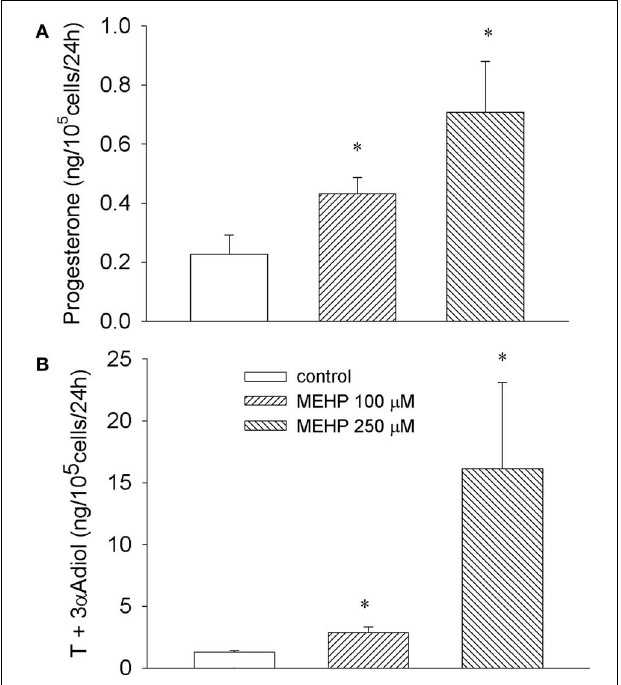
FIGURE 1 | Stimulatory effect of MEHP on basal steroidogenesis in immature granulosa cells (A) and Leydig cell progenitors (B). The cells were cultured without or with MEHP at different concentrations for 24h. Testosterone (T) and 5 α -androstane-3 α -17 β -diol (3 α -Adiol) in the culture medium from Leydig cells and progesterone from granulosa cell cultures were then measured by RIA.The mean values ± SEM for four independent steroidogenic cell preparations are presented. * p < 0.05, ** p < 0.01 compared to untreated